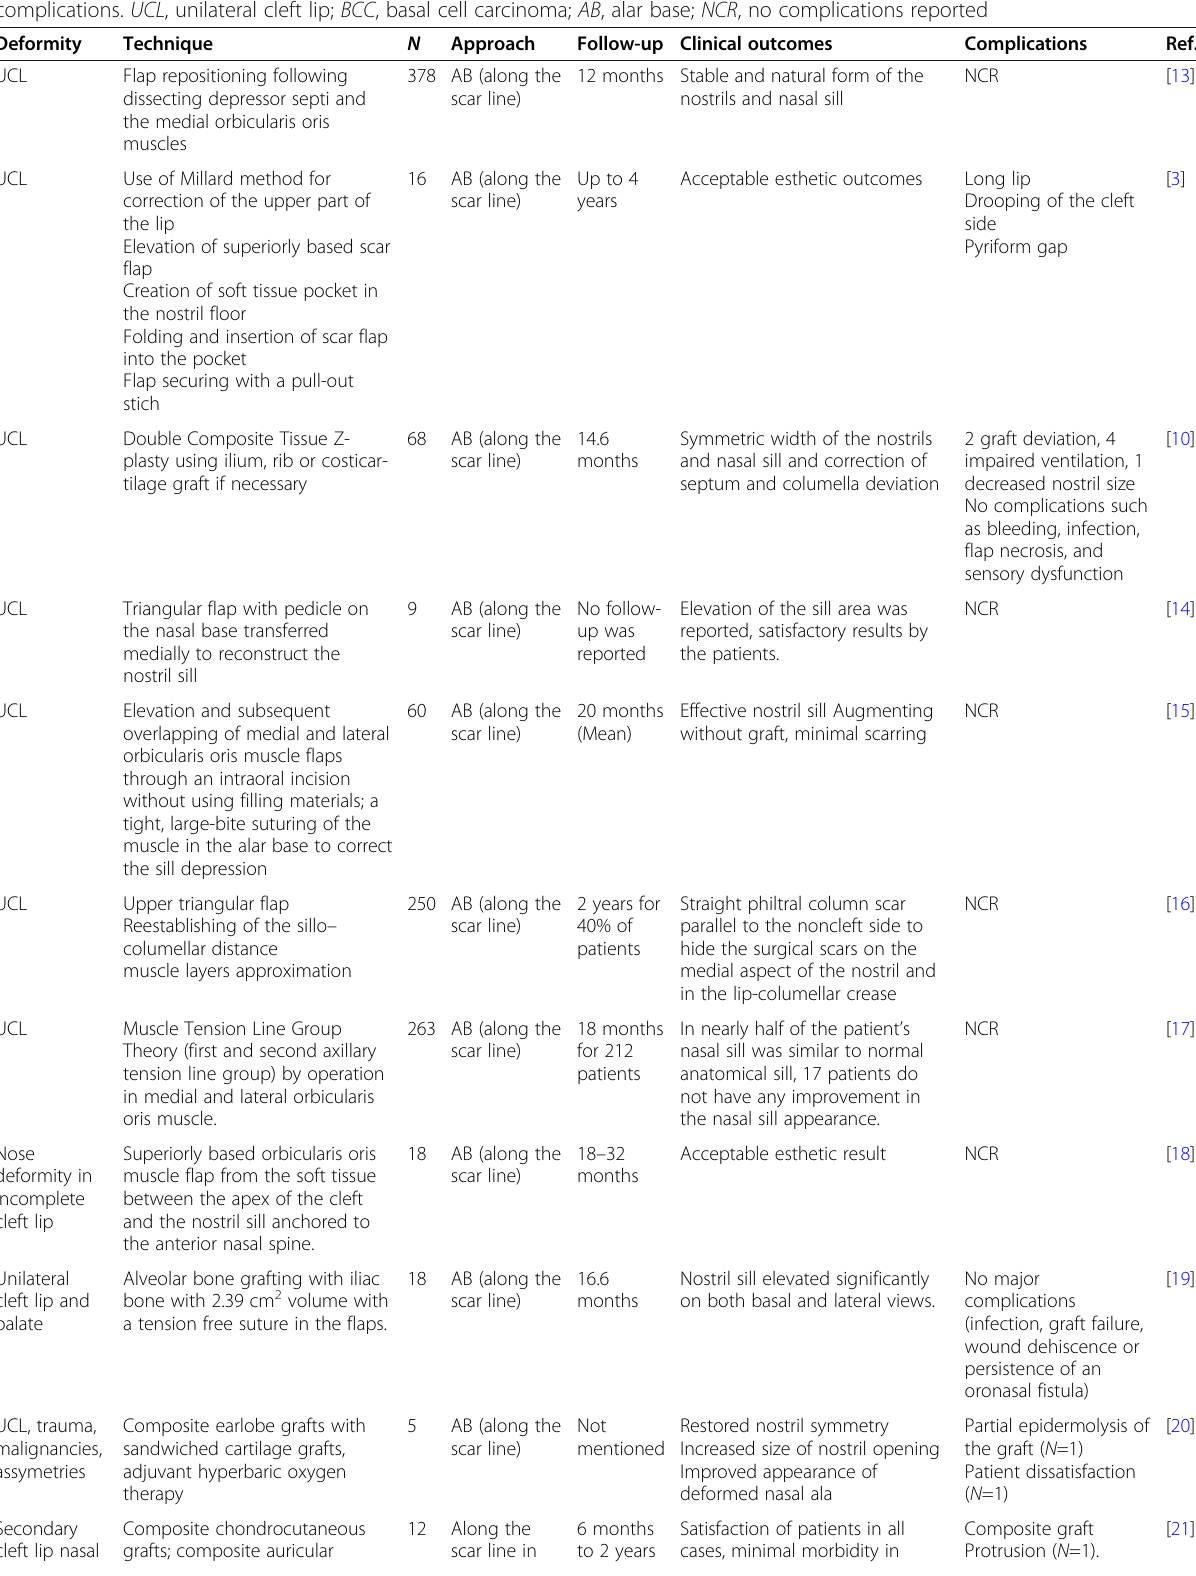
Table 2 The data of articles addressing the sill graft/augmentation in terms of the technique, approaches, clinical results, and complications. UCL , unilateral cleft lip; BCC , basal cell carcinoma; AB , alar base; NCR , no complications